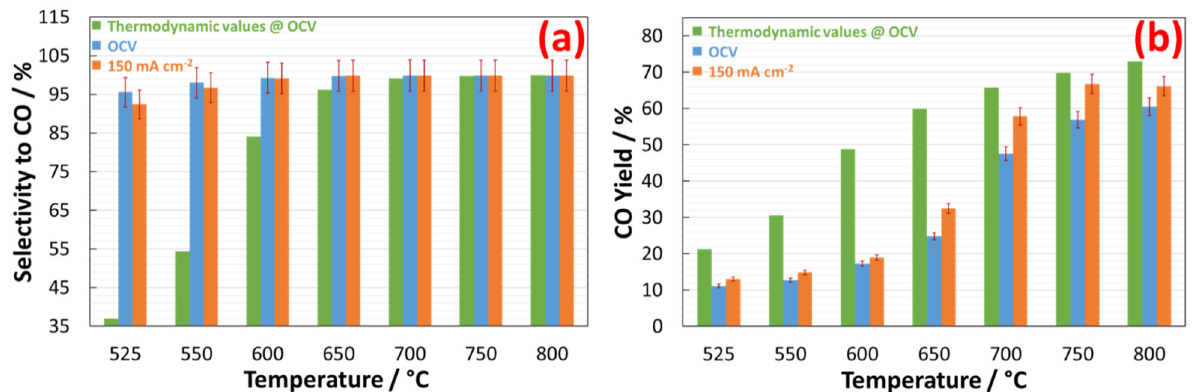
Figure 4. Trend of CO selectivity ( a ) and yield ( b ) treated according to Equations (5) and (6).